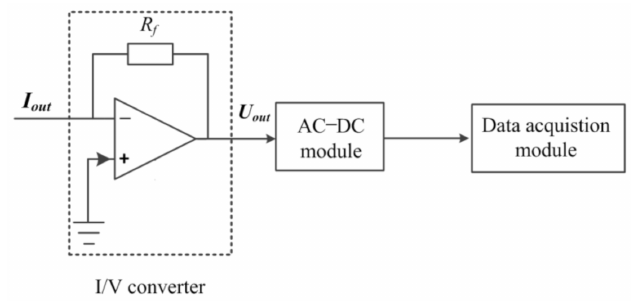
Figure 5. The flowchart of the current measurement.